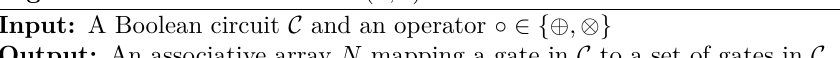
Algorithm 8 DetectOutcome ( C , ◦